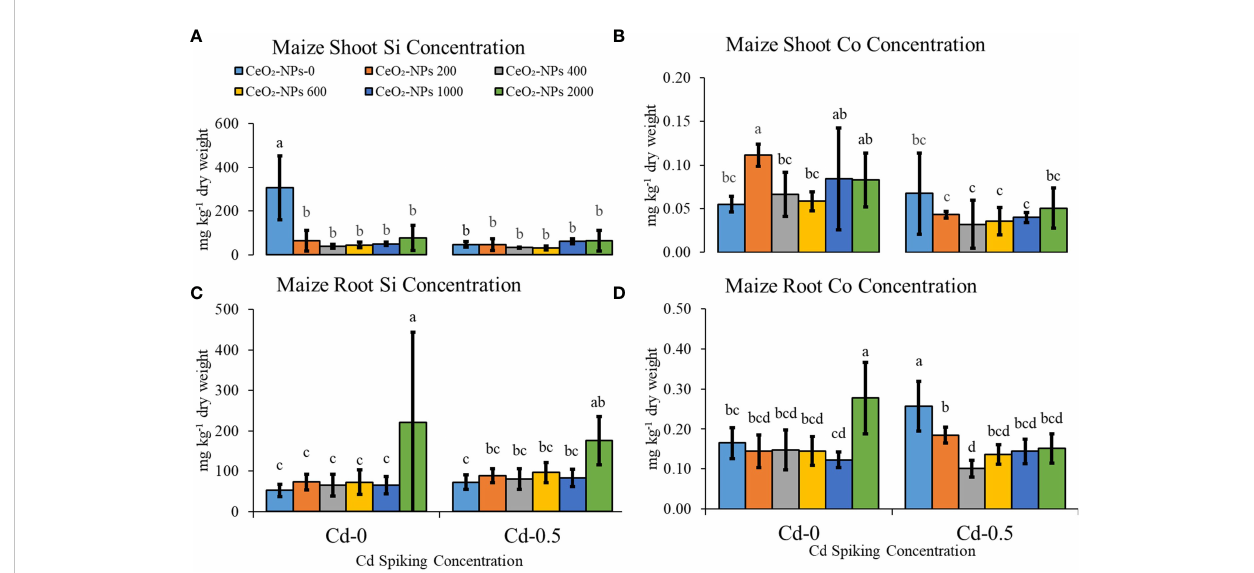
FIGURE 6 Effect of CeO 2 -NPs applied at 200, 400, 600, 1000 and 2000 mg kg -1 dry sand alone and in combination with 0.5 mg kg -1 Cd on maize Co and Si contents. (A) Shoot Si (mg kg -1 dry weight), (B) Shoot Co (mg kg -1 dry weight), (C) Root Si (mg kg -1 dry weight). (D) Root Co (mg kg -1 dry weight).